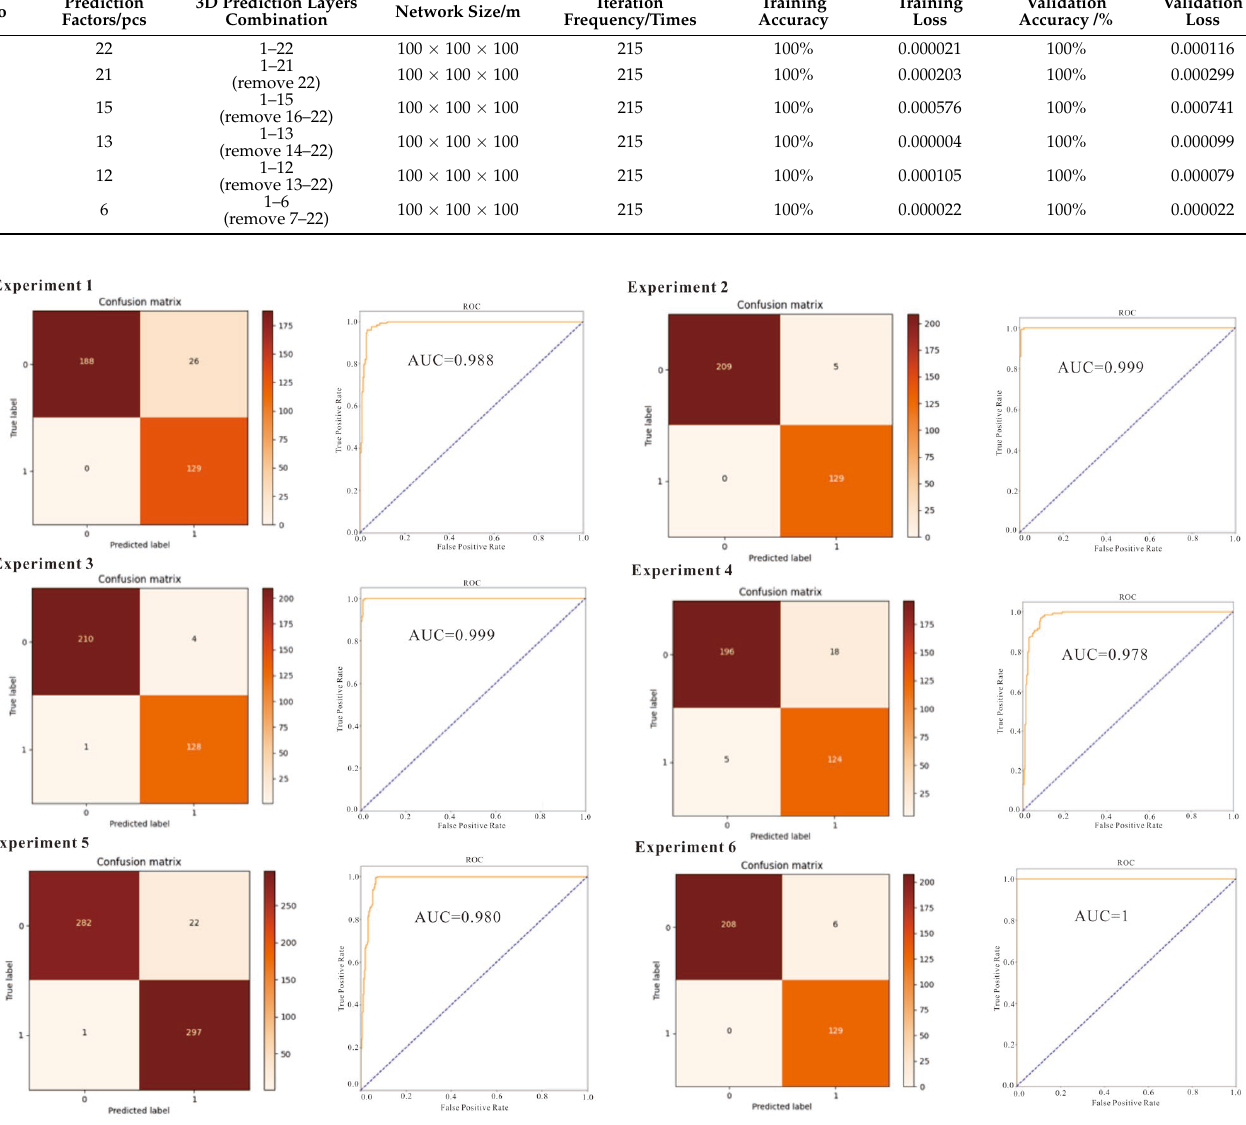
Figure 13. Comparison of the confusion matrix and ROC curves of the six groups of transfer learning models.